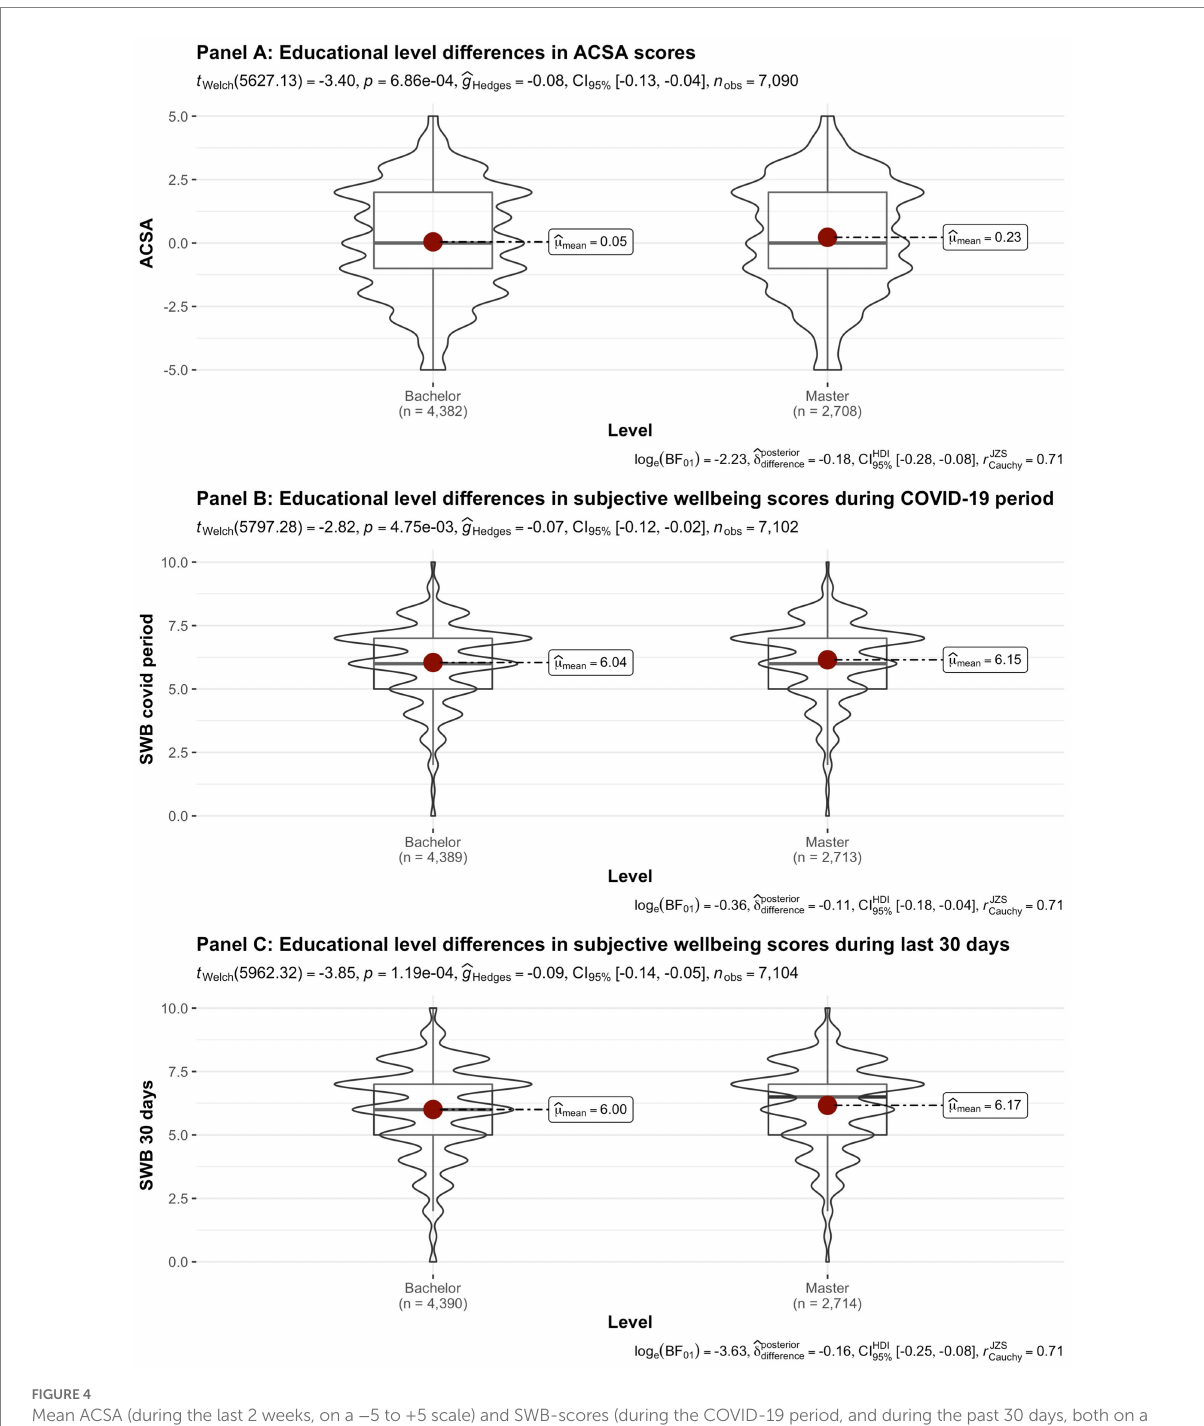
past 30 days ( mean = 6.07, SD = 1.78) were significantly lower [independent samples t -tests with t (7,134) = − 43.76, p < 0.001, Hedges’ g = 2.92, CI 95% = [2.85, 2.98] and t (7,136) = 6.-39.61, p < 0.001, Hedges’ g = 2.57, CI 95% = [2.51, 2.63], respectively] than SWB ratings obtained in a Belgian sample of university students in